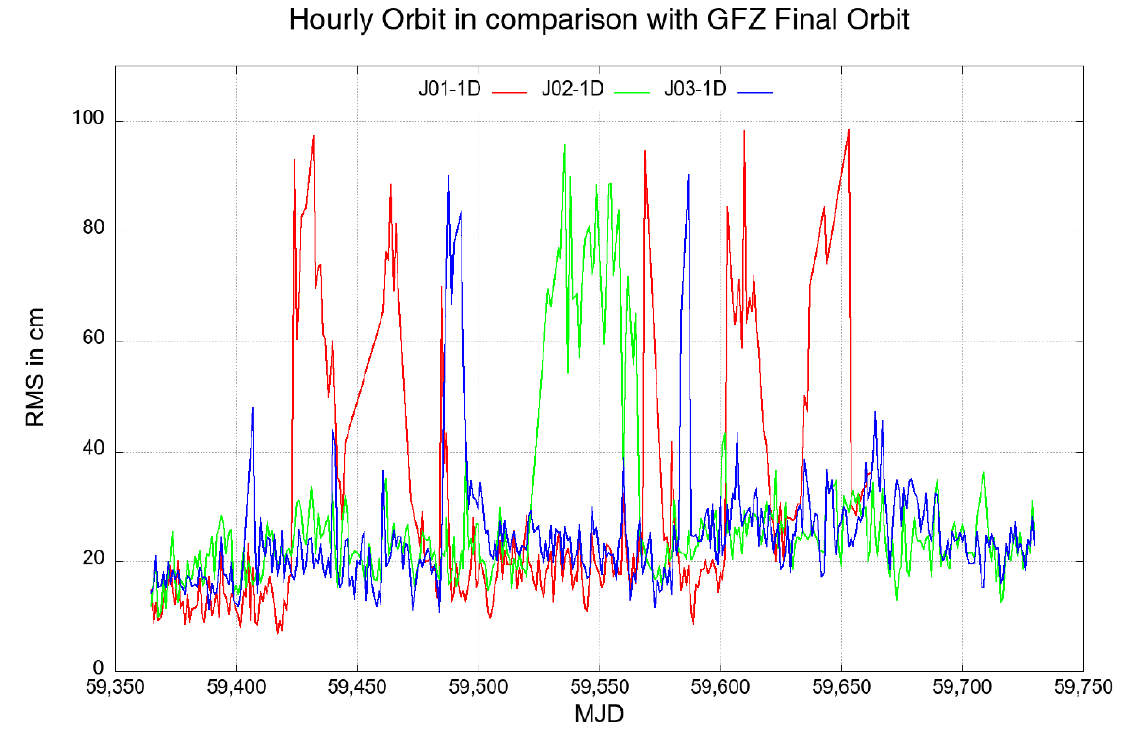
Figure 13. Time series in 1-D of QZSS NONE GEO satellites compared with GFZ final orbit.